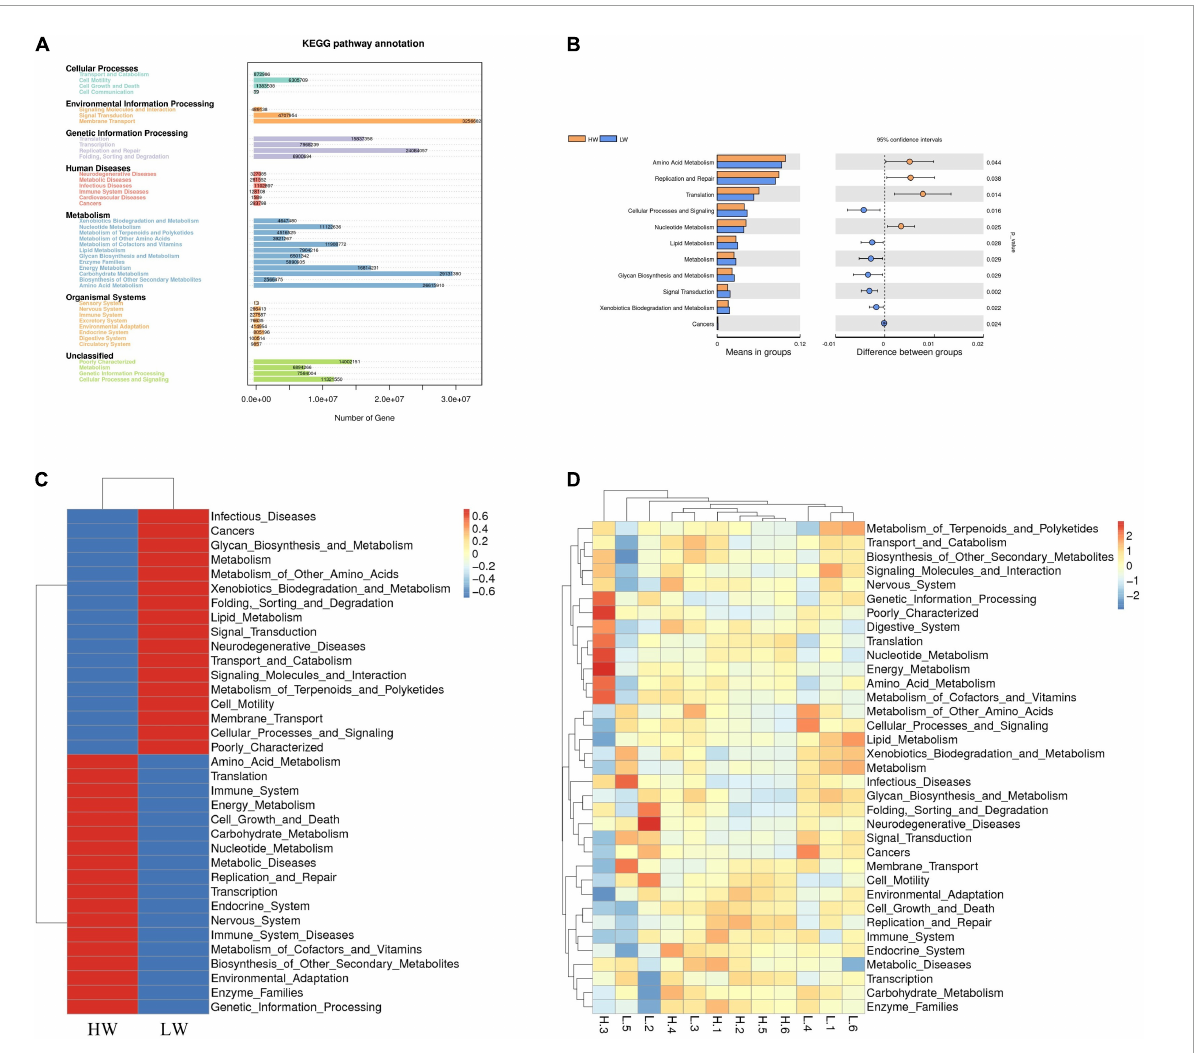
FIGURE6 Genomic functional predictions. (A) KEGG pathway annotation. (B) Heatmap clustered based on functional prediction of each sample in level 2 KEGG pathway. (C) Heatmap clustered based on functional prediction of the different groups in level 2 pathway. (D) Comparison of HW and LW groups in differential metabolic